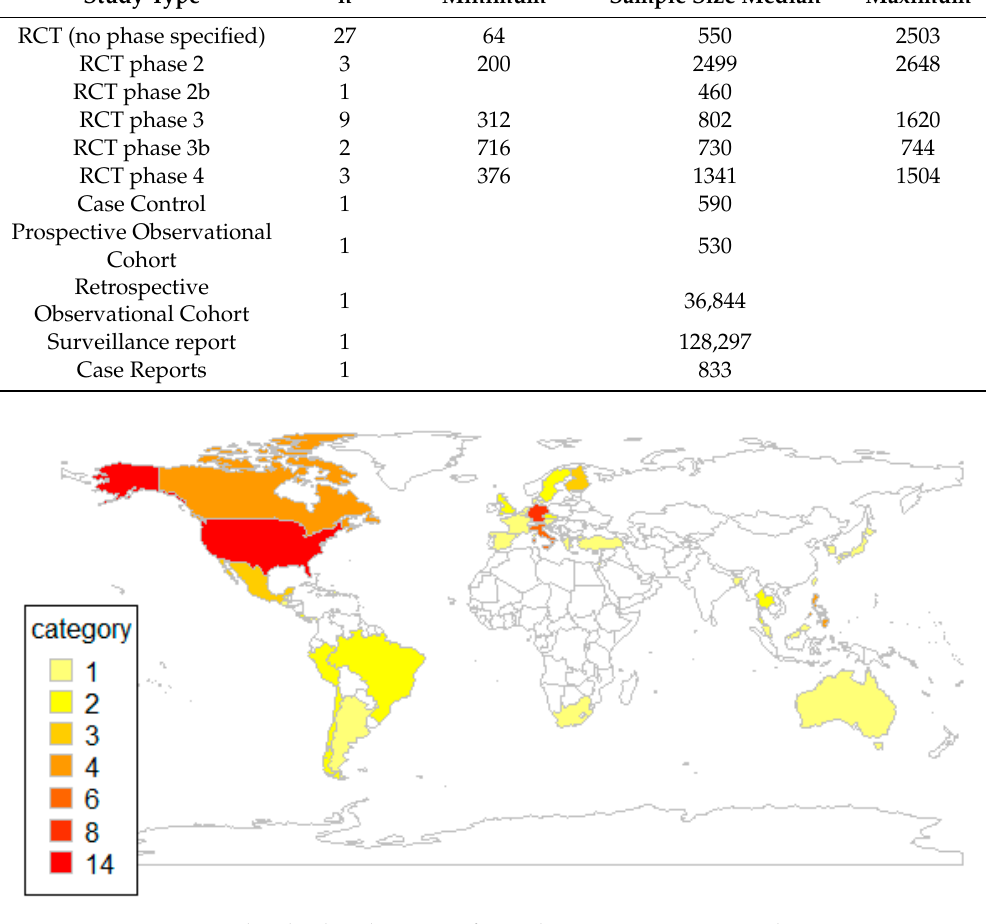
Figure 3. Geographical distribution of studies comparing co-administration versus separate administration.